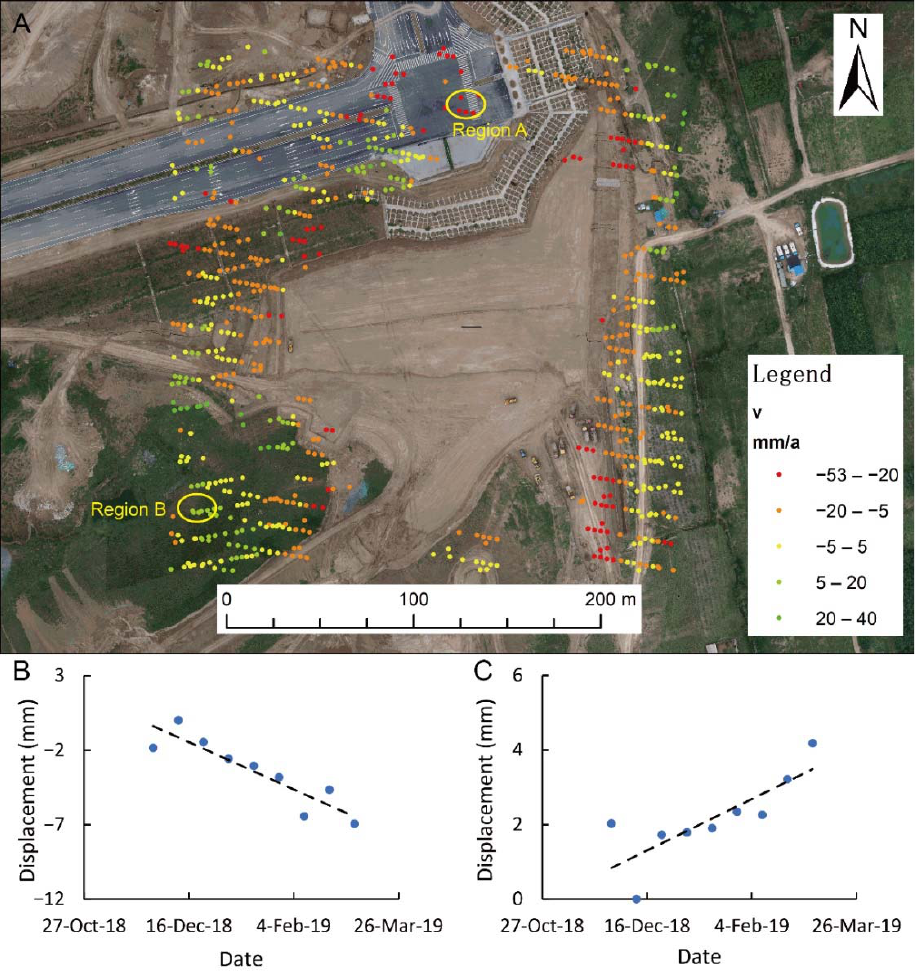
Figure 6. The vertical deformation based on InSAR data (( A ) is the spatial distribution of vertical deformation, ( B ) is the deformation in region A, and ( C ) is the deformation in region B). The characteristics of deformation in different areas are different. On the road, there is heterogeneity. There is significant settlement in region A (Figure 6B); however, there is an uplift in the excavation area (Figure 6C) throughout the winter break. The settlement in region A in Figure 6A appears to be more than 20 mm/year, which is affected by the filling projects. In the excavation area, the deformation rate is greater than 5 mm per year, which is related to the cutting